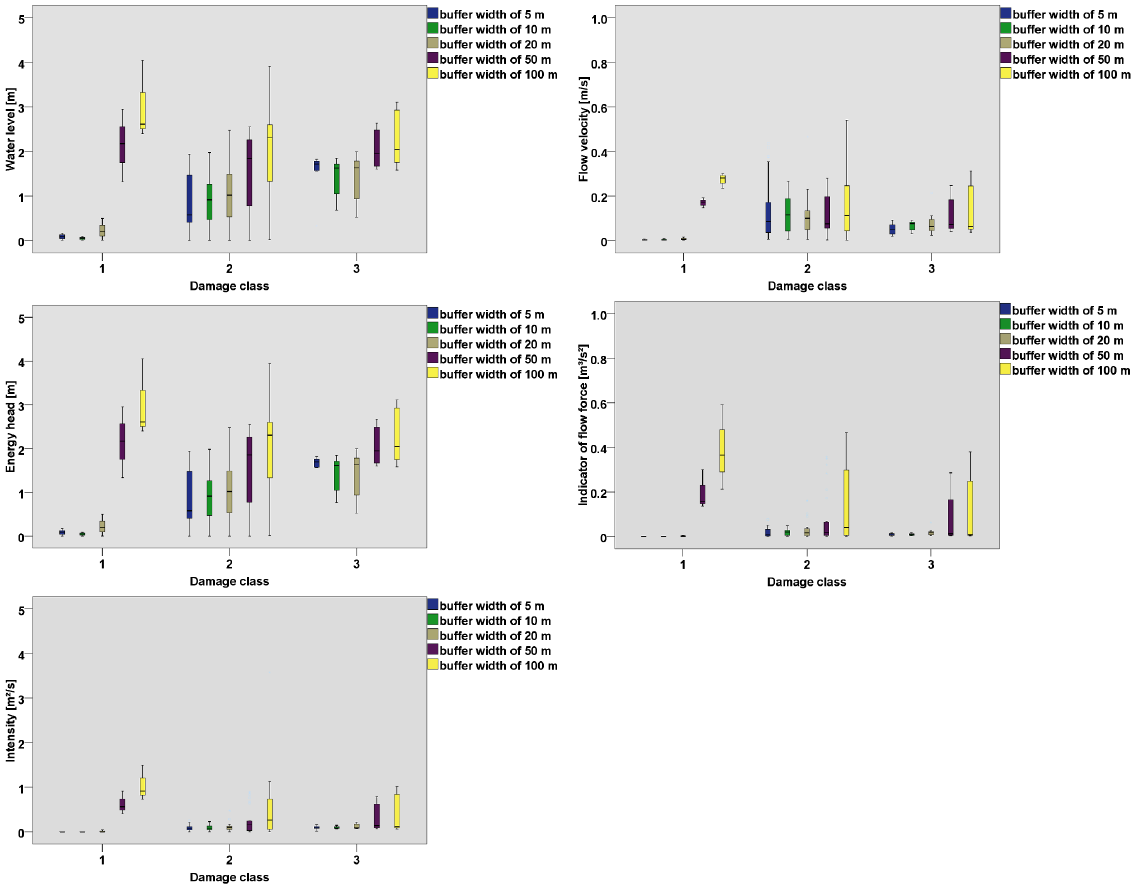
Figure 3. Box plots displaying the summary statistics of each impact parameter per damage class and for varying buffer widths.